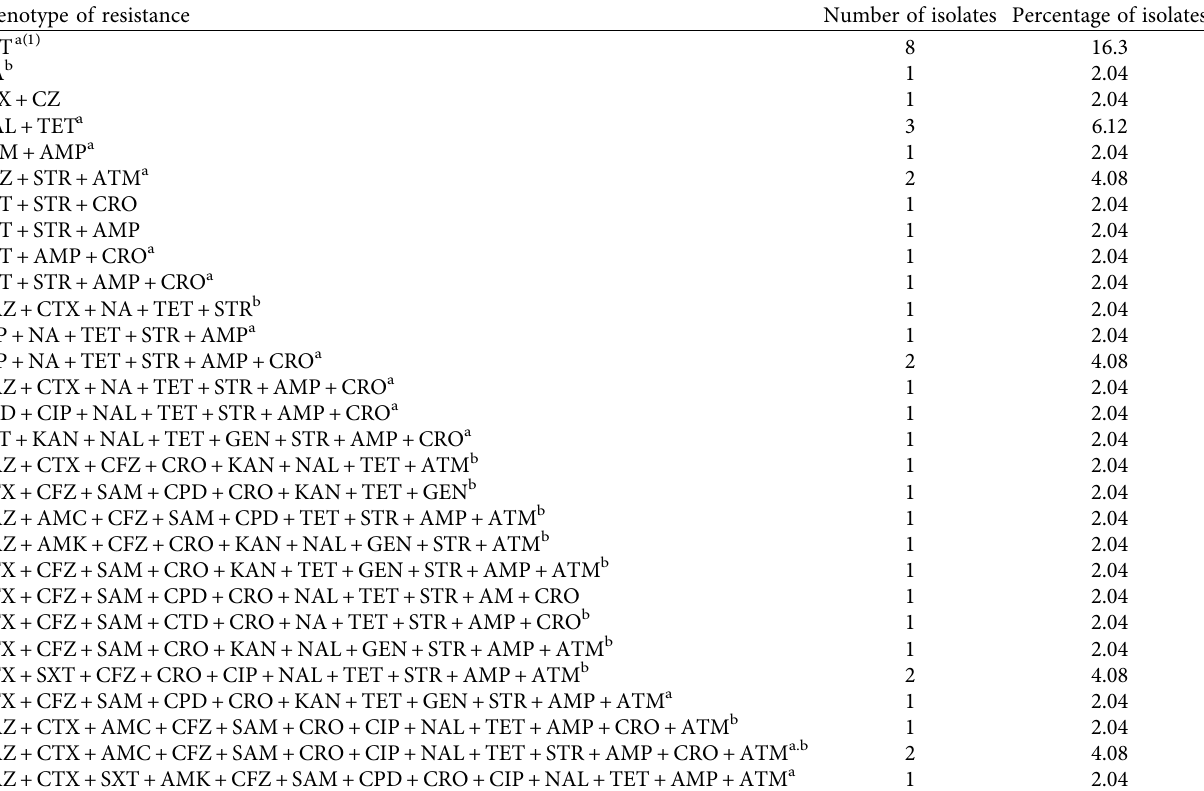
Table 3: Phenotypes of resistance detected among the E. coli isolates recovered from stray